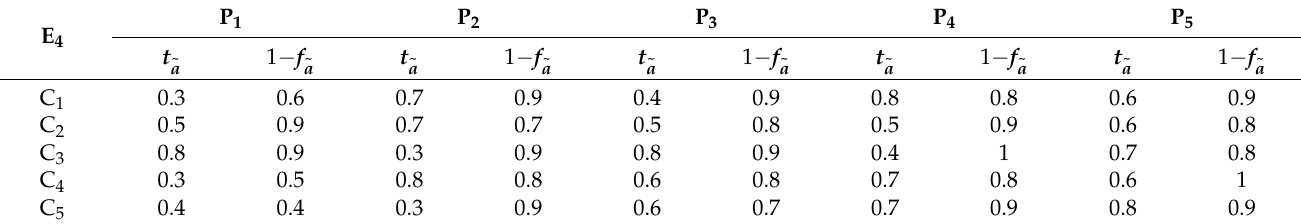
Table 17. Expert 4’s assessments on the different patients’ status.